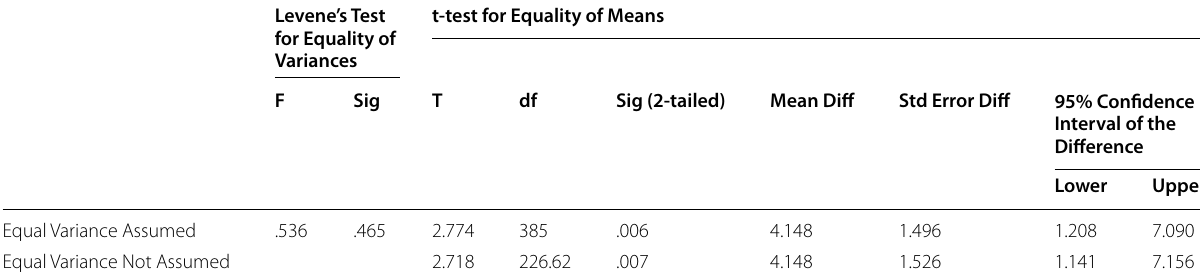
Table 6 Analysis of T-test